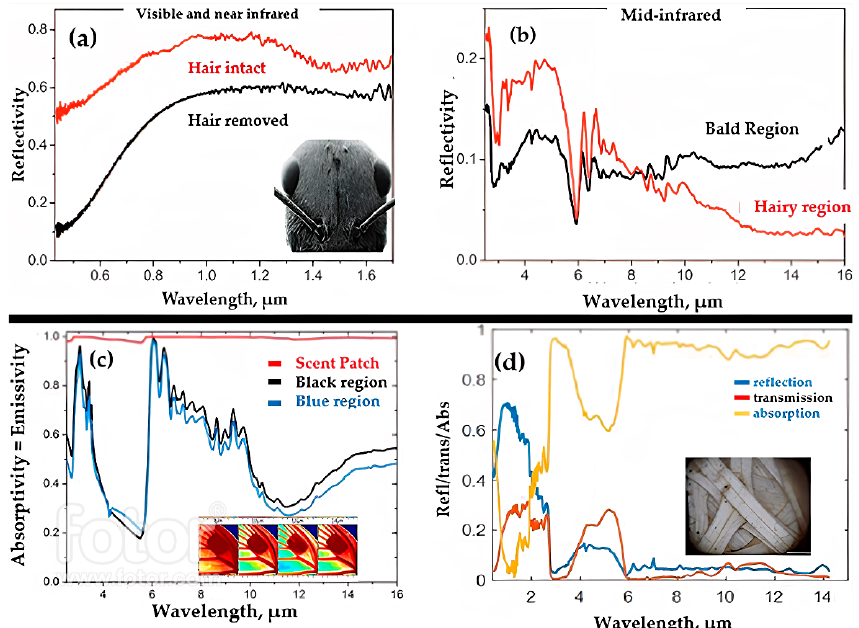
Figure 15. Daytime radiative cooling in nanostructured animals, the body surface of the Saharan silver ant investigated for reflectivity spectra in the ( a ) visible, near infrared (0.4–1.7 μ m), and ( b ) mid-infrared (2.5–16 μ m) regions, with and without hair, respectively. ( c ) Infrared absorptivity (=emissivity) spectra of various regions of the Bistonina intact forewing. ( d ) Reflection, transmission, and absorption spectra of a cocoon shell from 400 nm to 14 μ m, demonstrating high solar reflectance and thermal emittance [118–120].